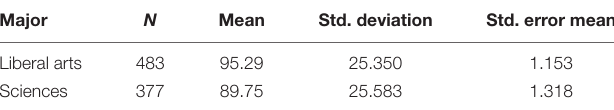
TABLE 4 | Descriptive analysis for major.